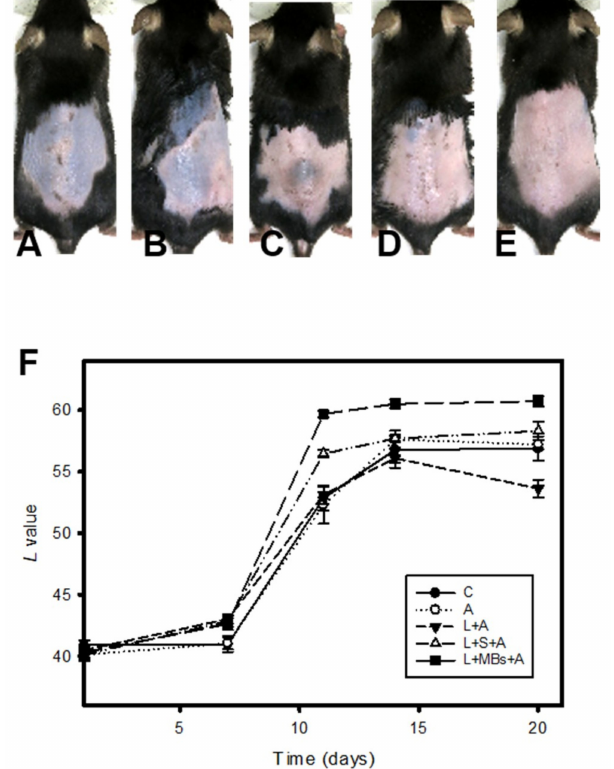
Figure 9. Photographs of mouse skin in group C ( A ); for the application of penetrating β -arbutin alone (group A) ( B ); for the laser irradiating the skin directly with the application of penetrating β -arbutin (group L + A) ( C ); for the laser irradiating the skin covered by saline and with the application of penetrating β -arbutin (group L + S + A) ( D ); and for the laser irradiating the skin combined with MBs on the skin and with the application of penetrating β -arbutin (group L + MBs + A) ( E ) over a 20-day treatment period; ( F ) Quantification of the skin-whitening effects of β -arbutin on ultraviolet-radiation-induced hyperpigmentation for the groups in panels ( A – E ). Data are mean and SD